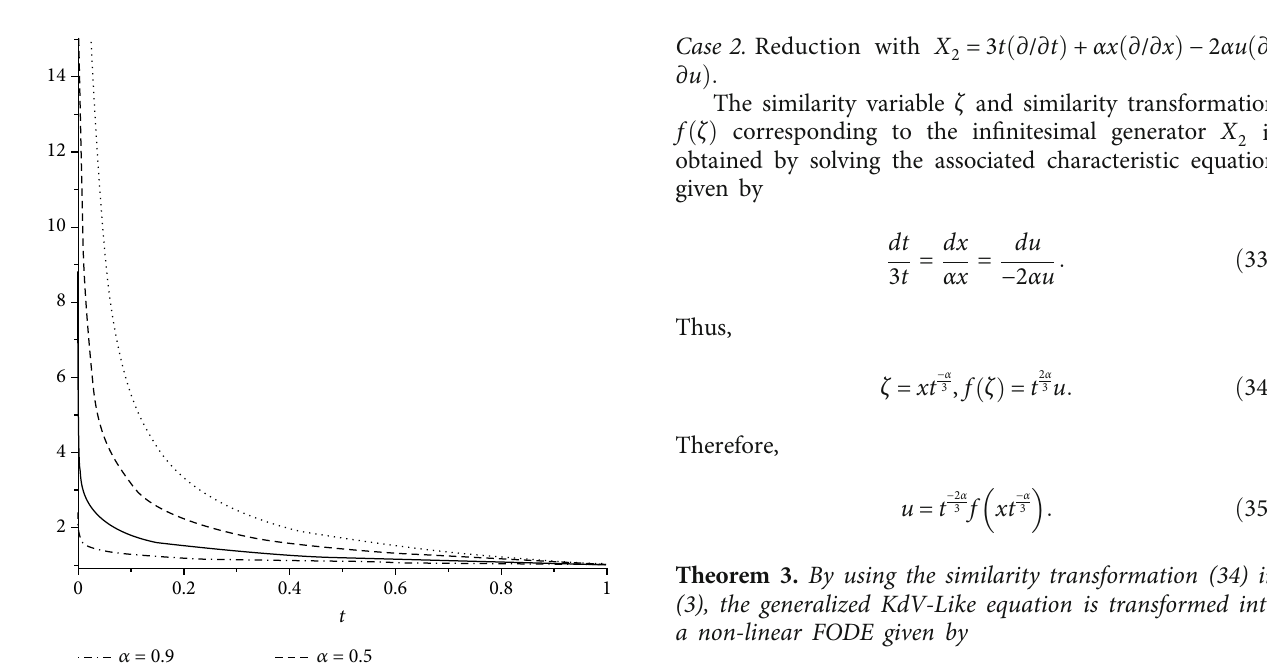
Figure 1: The solution u α = 0 : 75 , α = 0 : 5 , α = 0 : 25